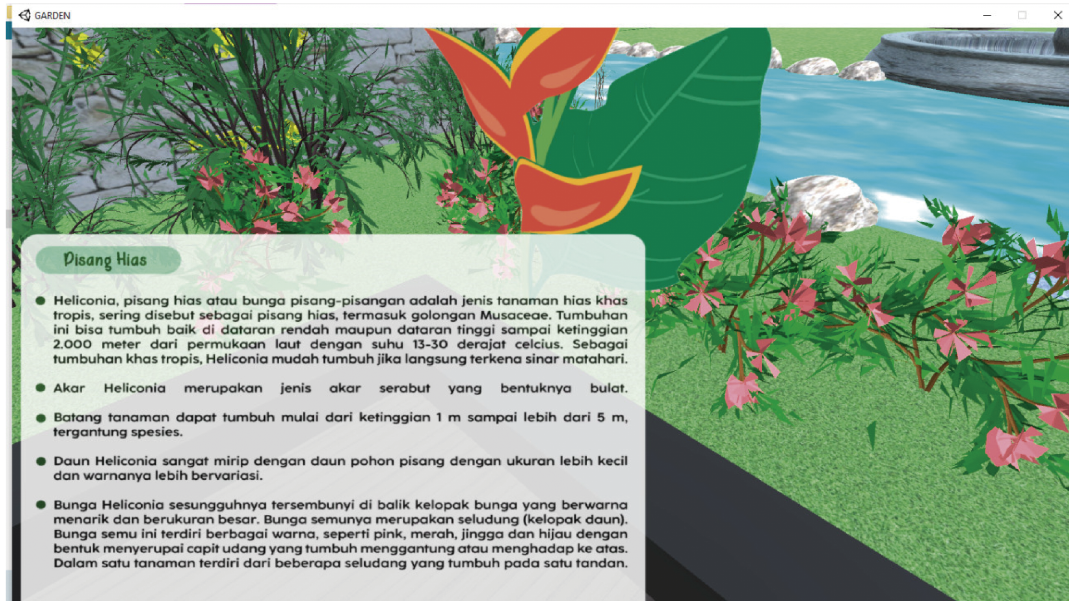
Figure 4. Virtual Garden Content